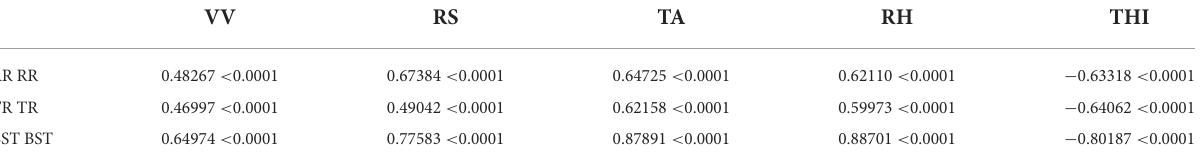
TABLE 2 Correlation between environmental and physiological variables studied for